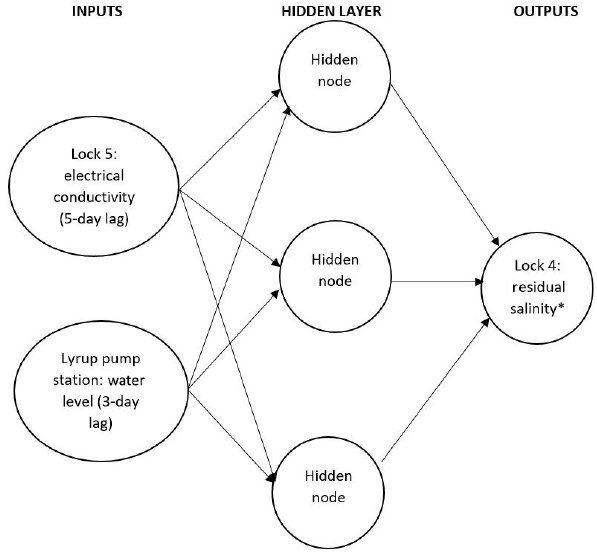
Figure 6. Structure and inputs of ANN model for predicting saline groundwater accession as part of the hybrid model (model 2). The residual salinity output is the difference between the measured salinity and the output from the process-driven salt transport model for all flow rates that are less than 15000MLday − 1